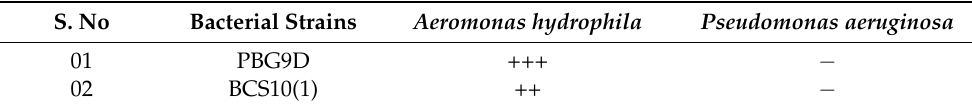
Table 2. Antimicrobial activity of bacterial strains against fish pathogens. S. No Bacterial Strains Aeromonas hydrophila